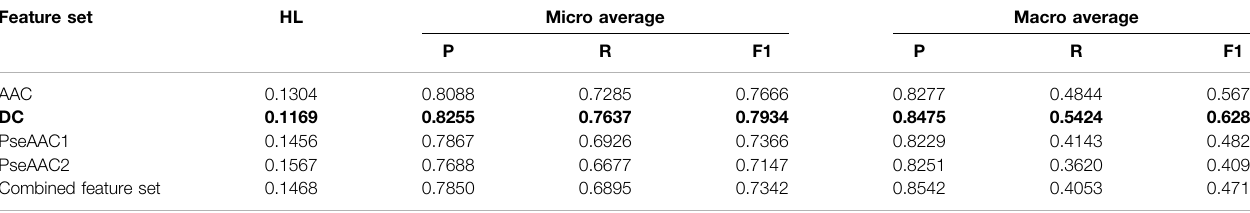
TABLE 5 | Training performance outcome for LP-RF-AdaBoost classi fi er (Note that the best performing feature set is shown in bold). Feature set